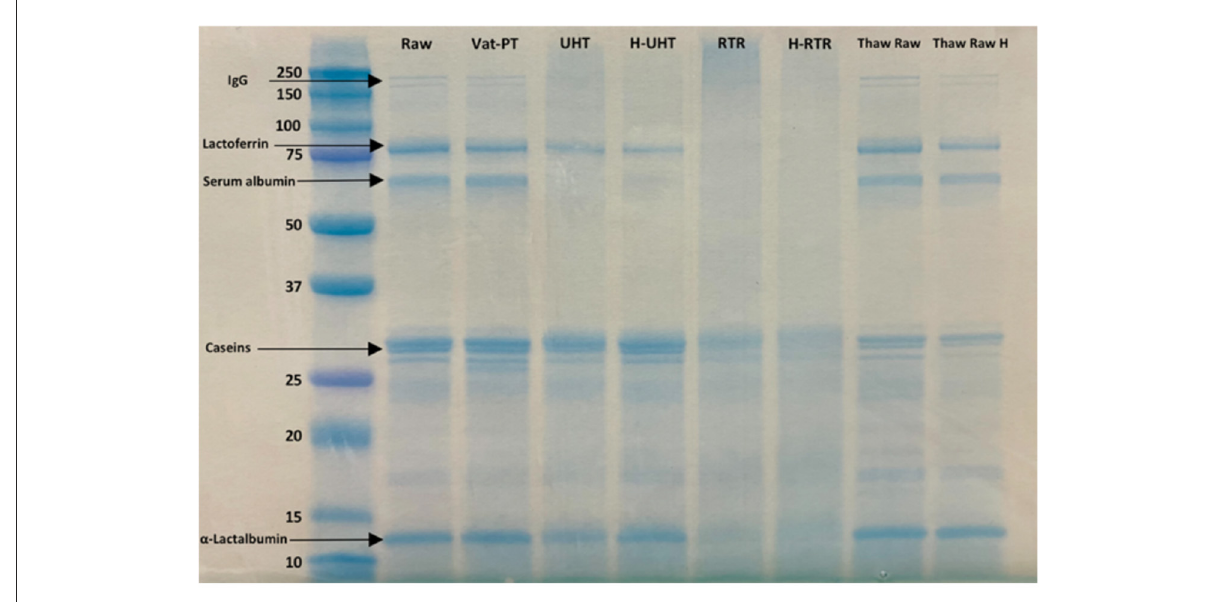
FIGURE1 SDS-PAGE of raw milk (Raw), vat-pasteurized milk (Vat-PT), ultra-high-temperature processed milk (UHT), homogenized and ultra-high-temperature processed milk (H-UHT), retort processed milk (RTR), homogenized and retort processed milk (H-RTR), thawed raw milk (Thaw Raw), and homogenized thawed raw donor human milk (Thaw Raw H). The unit of the y-axis is kDa.